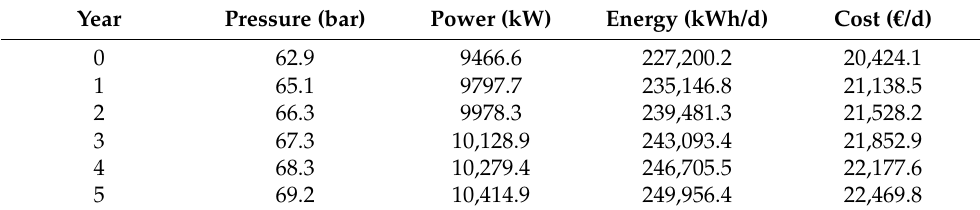
Table 5. Pressure increases without membrane replacement at 27 ◦